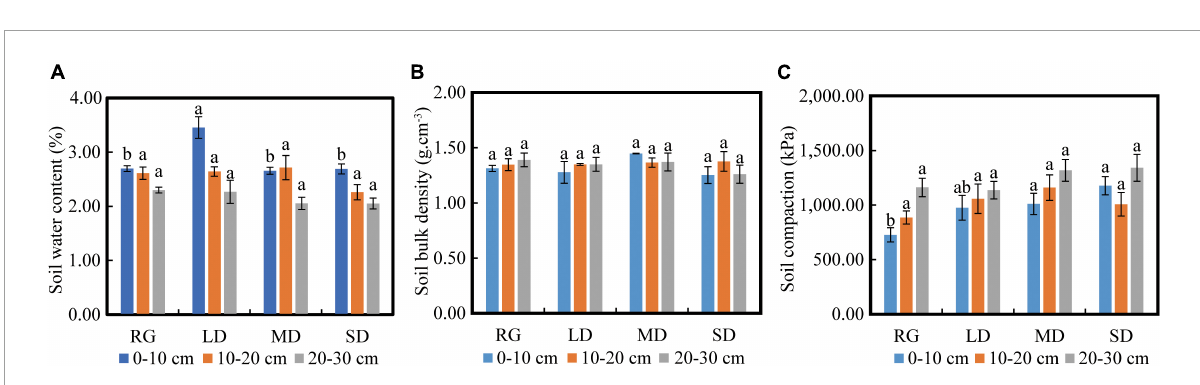
FIGURE4 Changes in soil water content (A) , soil bulk density (B) , and soil compaction (C) of different grasslands. LD, lightly degraded grassland; MD, moderately degraded grassland; SD, severely degraded grassland; RG, reseeded grassland. Different letters indicate significant differences between groups ( P <